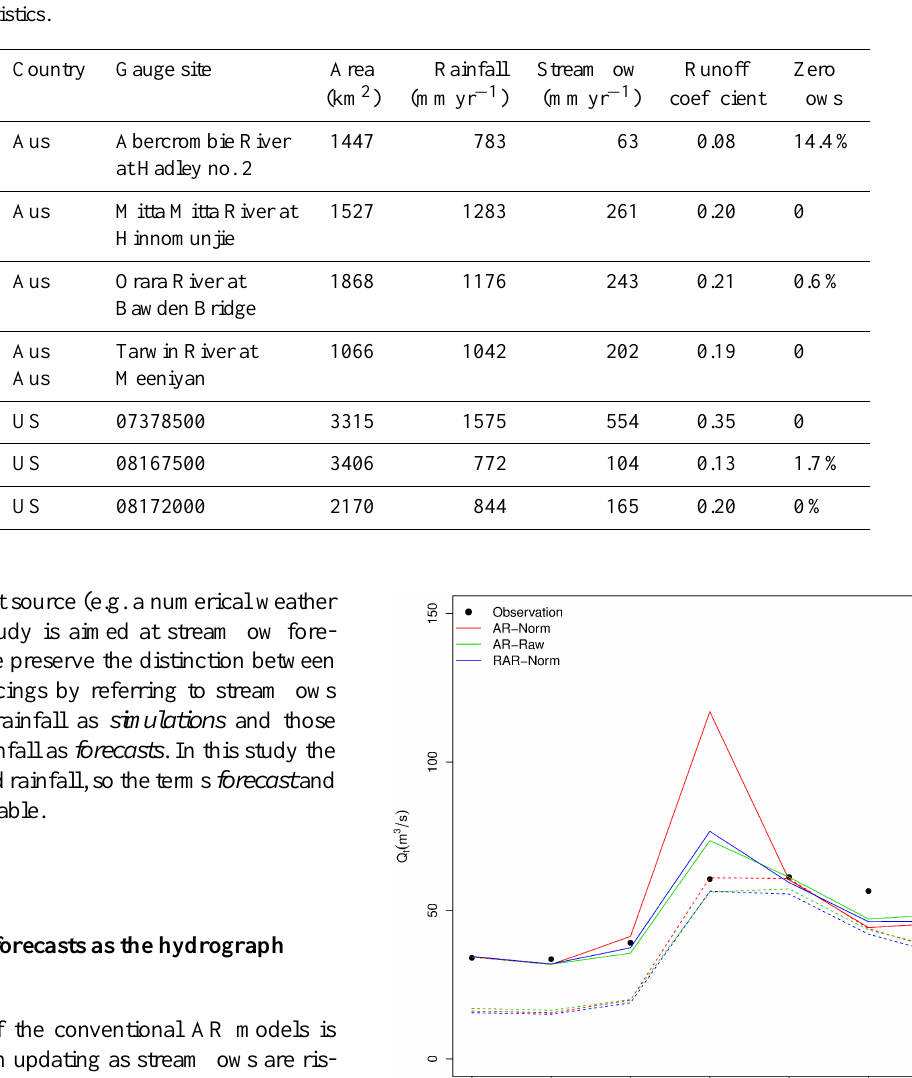
Table 1. Catchment characteristics.